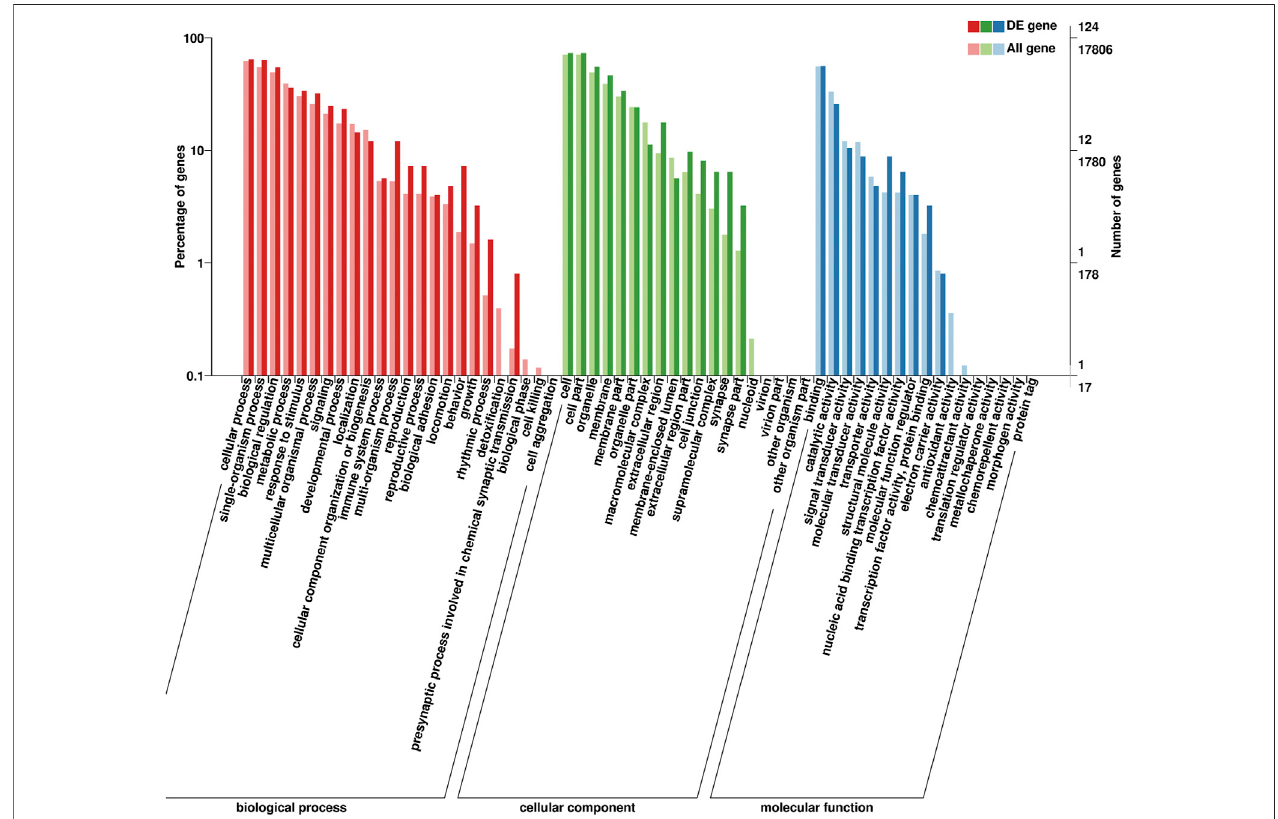
FIGURE 7 | Gene Ontology (GO) classi fi cation of 166 DEGs. GO terms are summarized in three main categories: cellular components, molecular functions, and biological processes.